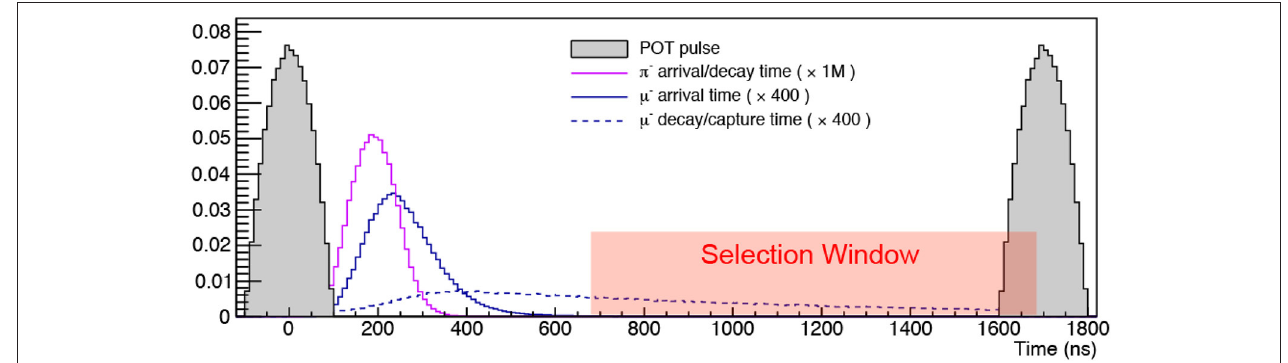
FIGURE 2 | The Mu2e beam timing. A pulse with ≈ 3.9 × 10 7 , 8 GeV kinetic energy protons arrives every 1,695 ns. The arrival time distribution for pions that arrive at the detector solenoid (greatly reduced by the Mu2e Solenoid system) are shown, along with the arrival time for muons and the decay or capture time (both with an 864 ns lifetime). The “Selection window” is the period of time for which Mu2e will analyze data; the live gate will take data as early as about 500 ns, with the final accepted region determined through analysis. The pulse shape is more complicated than the idealized form shown here. See Bartoszek et al. [8] for more